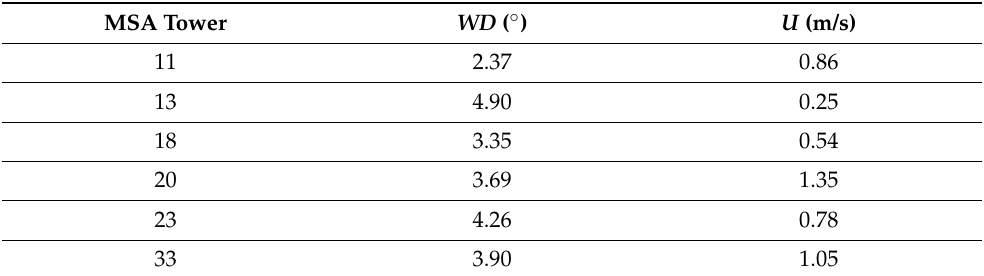
Table 2. RMSE values at each tower during synoptic forced period of 17 April